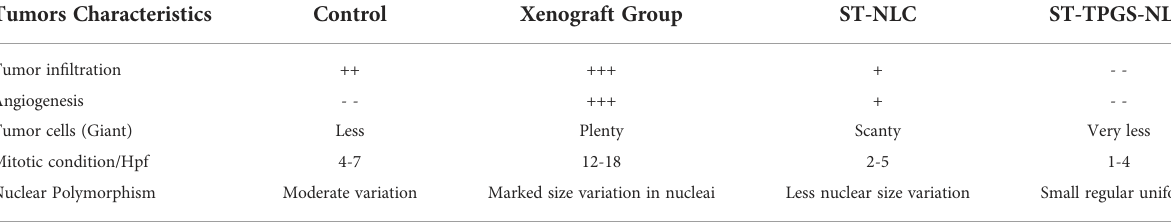
TABLE 5 Characteristics of xenograft tumors generated in